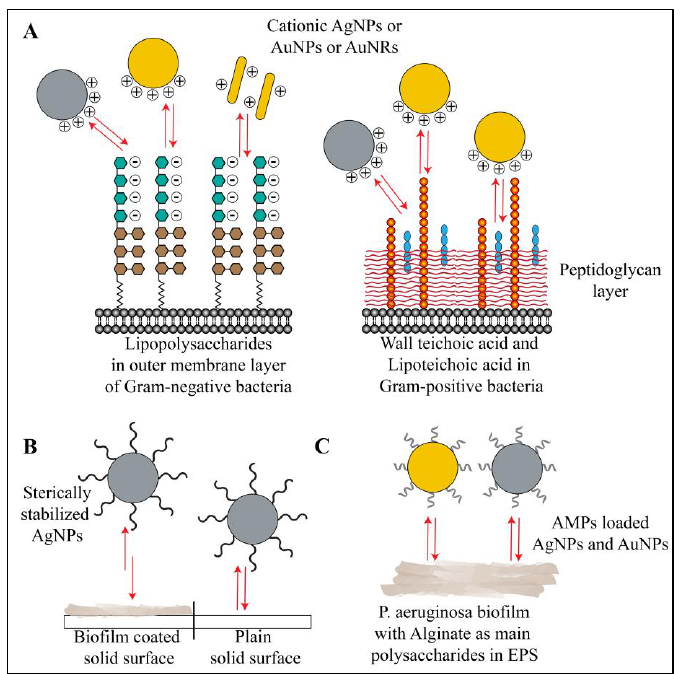
Figure 4. Schematic representation of interactions between gold or silver nanoparticles and polysaccharides of biofilm. ( A ) Bacterial polysaccharides (LPS, teichoic acid and lipoteichoic acid) show electrostatic interactions, hydrogen-bonding interactions and hydrophobic interactions with cationic gold and silver nanoparticles. Neutral and anionic gold and silver nanoparticles show no or minimal interactions under the same experimental conditions. ( B ) In some cases, the nanoparticles stabilized with large, non-ionic polymers (e.g., PVP coated AgNPs) show specific electrosteric repulsive interactions with biofilm polysaccharides. ( C ) Antimicrobial peptide coated gold and silver nanoparticles show electrostatic as well as hydrophobic interactions with biofilm polysaccharides (e.g., alginate in P. aeruginosa biofilm). Red arrows in the figure indicate all types of interactions.